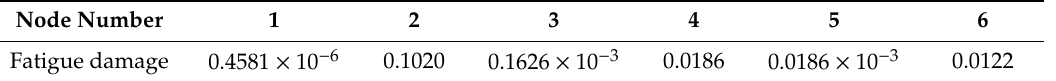
Figure 6. Matrix plot of fatigue damage of different mean strains and strain ranges: ( a ) Node 1; ( b ) Node 2; ( c ) Node 3; ( d ) Node 4; ( e ) Node 5; ( f ) Node 6. Table 2. Fatigue damage of Nodes 1–6 in 20 years.